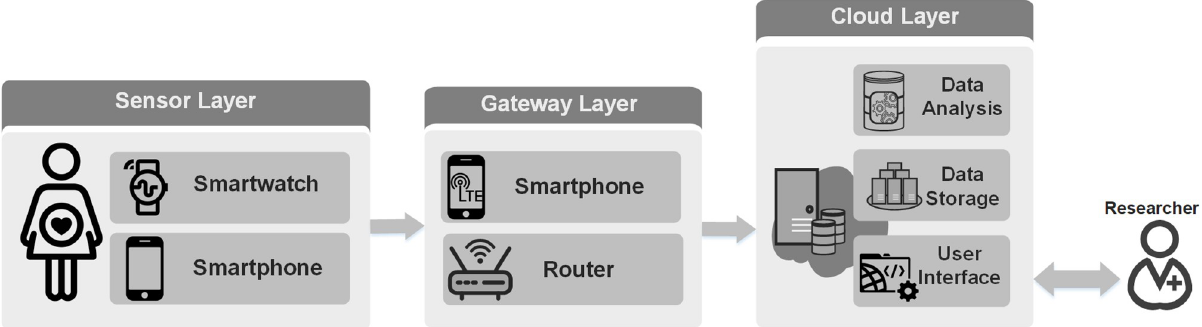
Fig 1. IoT-based remote monitoring system. First, the sensor layer performs health data collection, utilizing a smartwatch and a smartphone. Second, the gateway layer acts as a bridge between the devices and the remote server, transmitting the collected data to our remote servers. Third, the cloud layer is responsible for data storage and data analysis. A user interface is also provided for data